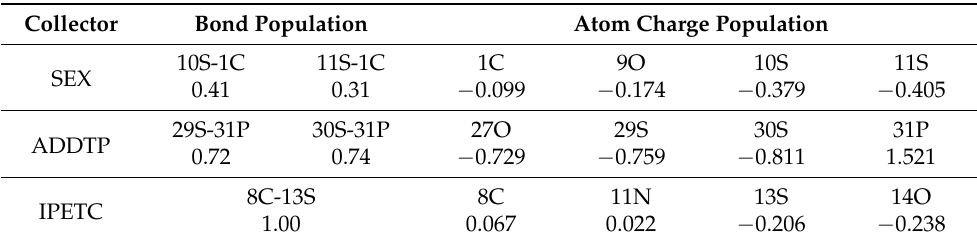
Table 8. Mulliken populations of C=S or P=S bond and atom charge of